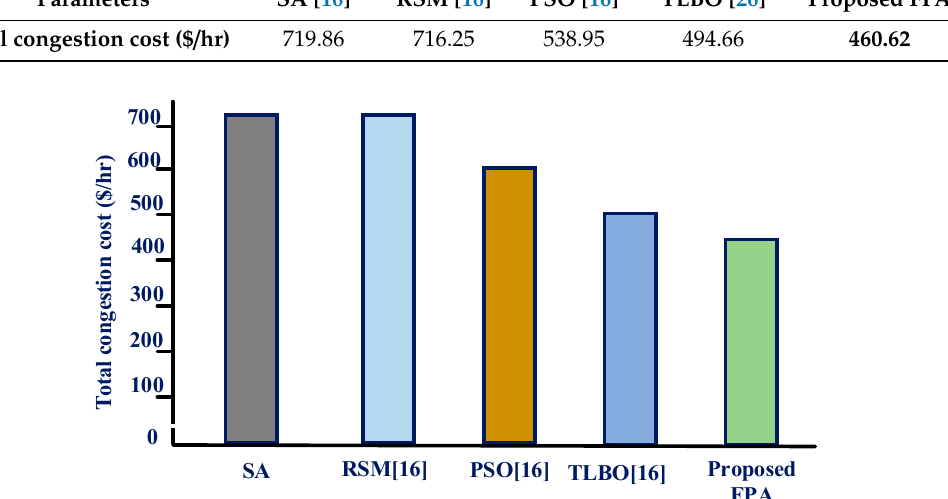
Energies 2019 , 12 , x FOR PEER REVIEW ff ectiveness of proposed FPA with other optimization techniques. Figure 10. Effectiveness of proposed FPA with other optimization techniques. Figure 10. E